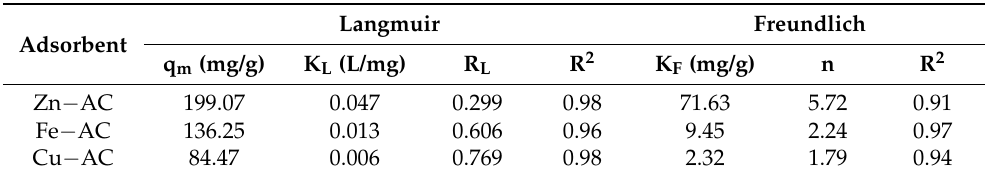
Figure 8. The adsorption isotherm curves of Cr(VI) onto the samples: ( a ) Zn − AC; ( b ) Fe − AC; ( c ) Cu − AC. Table 2. Parameters of the isotherm models for Cr(VI) adsorption onto activated carbon derived from WPTs.